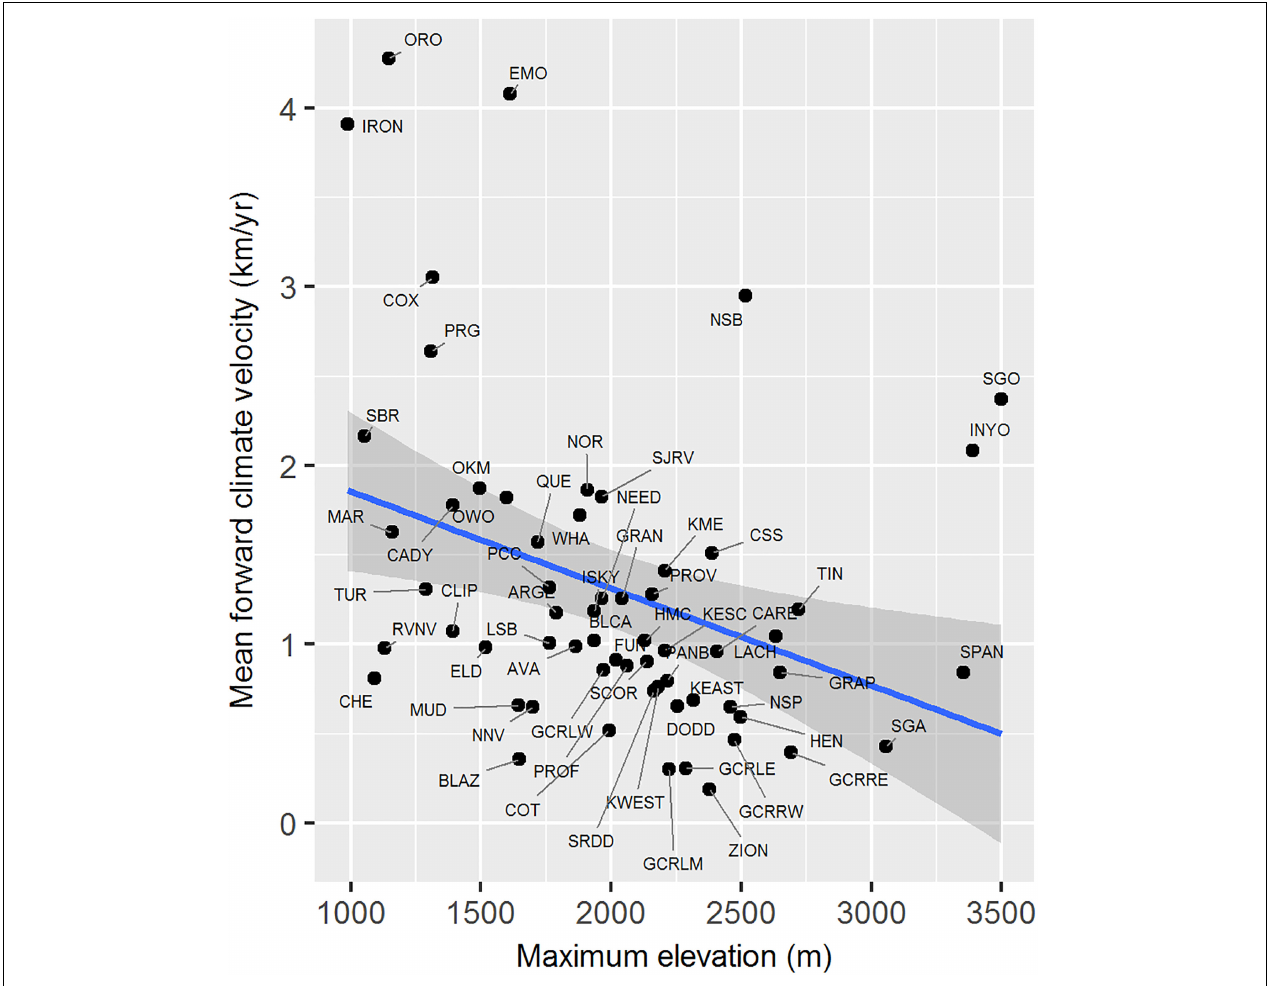
FIGURE 8 | Relationship between mean forward climate velocity and maximum elevation of habitat polygons associated with desert bighorn sheep populations. Blue line and dark gray band show best fit line and 95 percent confidence interval, respectively, from linear regression model. See Table 1 for full population names. White Mts. population was removed as an extreme outlier (mean forward climate velocity = 12.73 km/year; maximum elevation = 4,322 m) prior to fitting regression